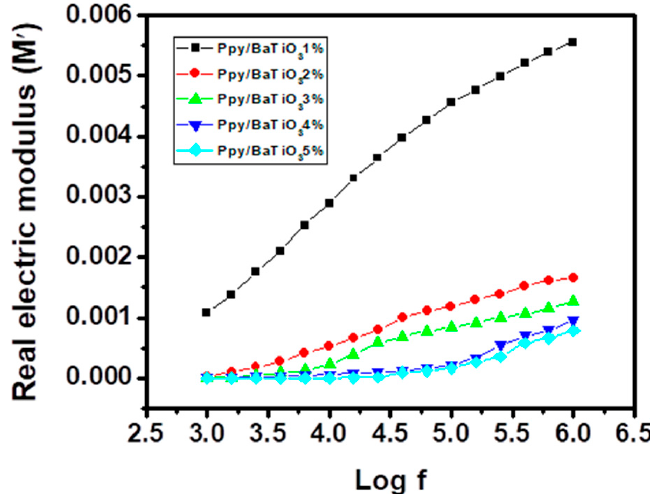
Figure 13. Variation of real part of electric modulus with frequency for PPy/BaTiO 3 composites.